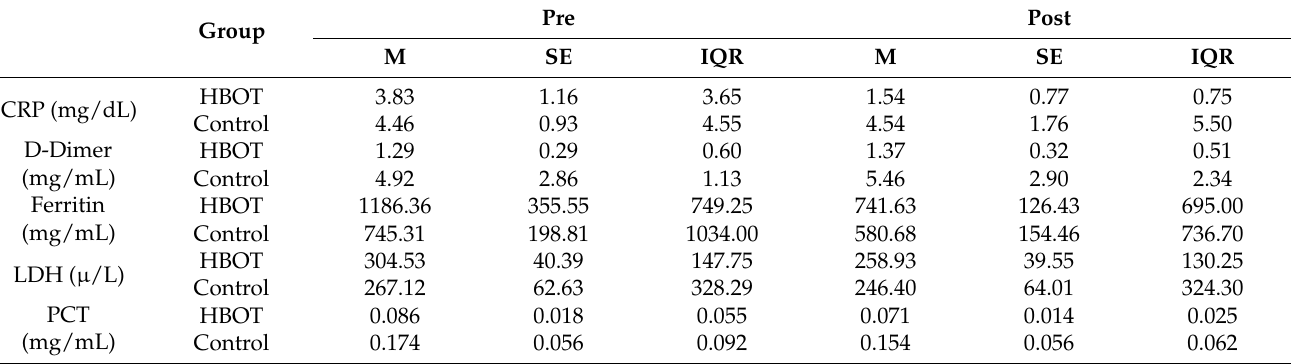
Table 2. Biochemical tests at the beginning and at the end of the study in HBOT and control group.